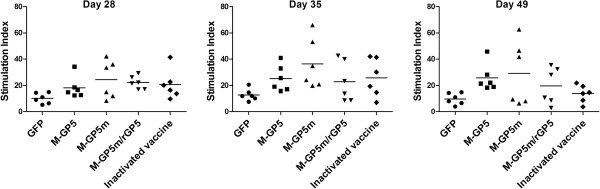
Lymphocyte proliferative responses in pigs immunized with recombinant adenoviruses. Peripheral blood mononuclear cells in quadruplicate were stimulated with inactivated PRRSV (MOI of 200) during 72 h. Cells were labeled with radioactive H3-thymidine incorporated DNA 18 h before cell harvesting. The data are expressed as stimulation index (SI) which represents the ratio of mean CPM of cells stimulated with the antigen divided by the mean of CPM of cells without antigen. Data represent the individual responses of each pig and the means of the group (n = 6 per group) at 28, 35 and 49 days post-immunization are represented by the horizontal bars.